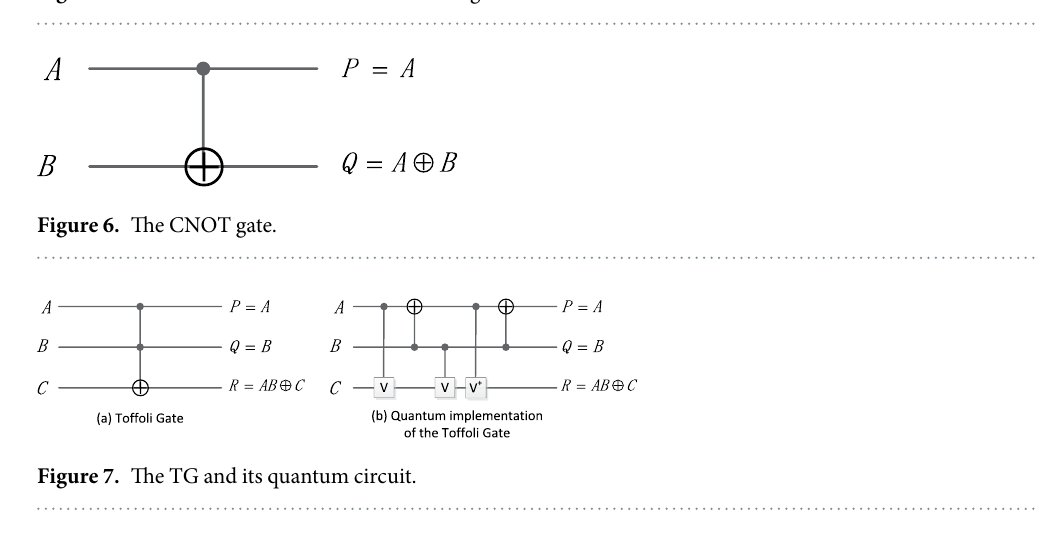
Figure 5. The Controlled- V and Controlled- V + gates.